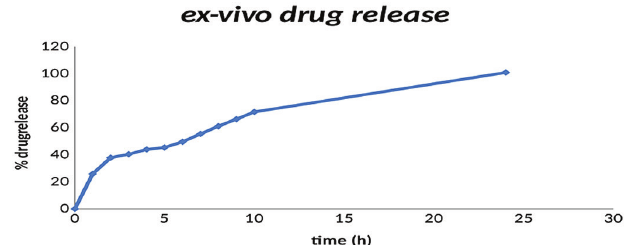
FIGURE 8 - Ex-vivo drug release of optimized batch of methotrexate coateds